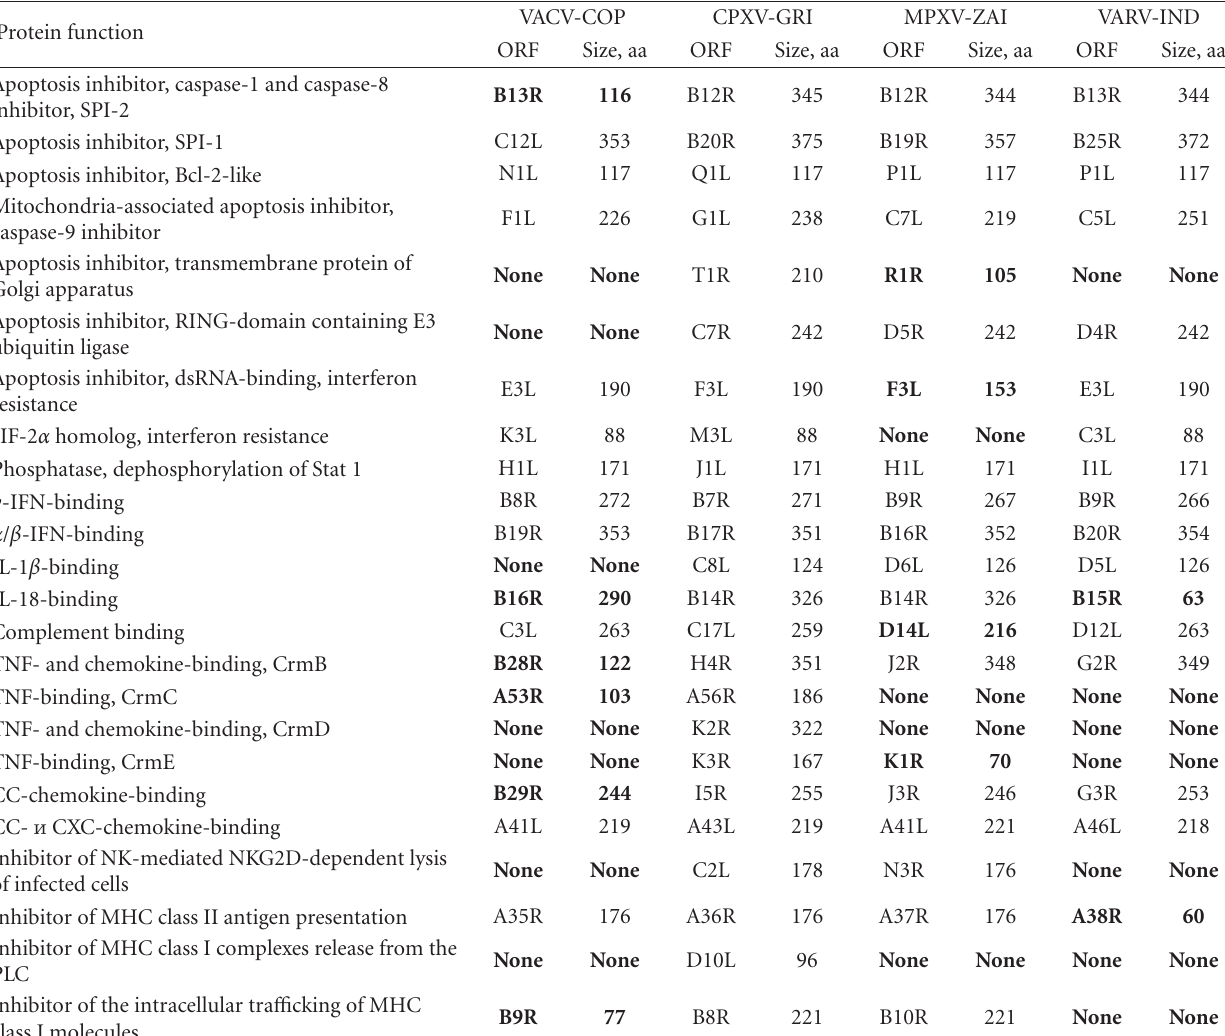
Table 4: Orthopoxviral proteins modulating defense reactions of